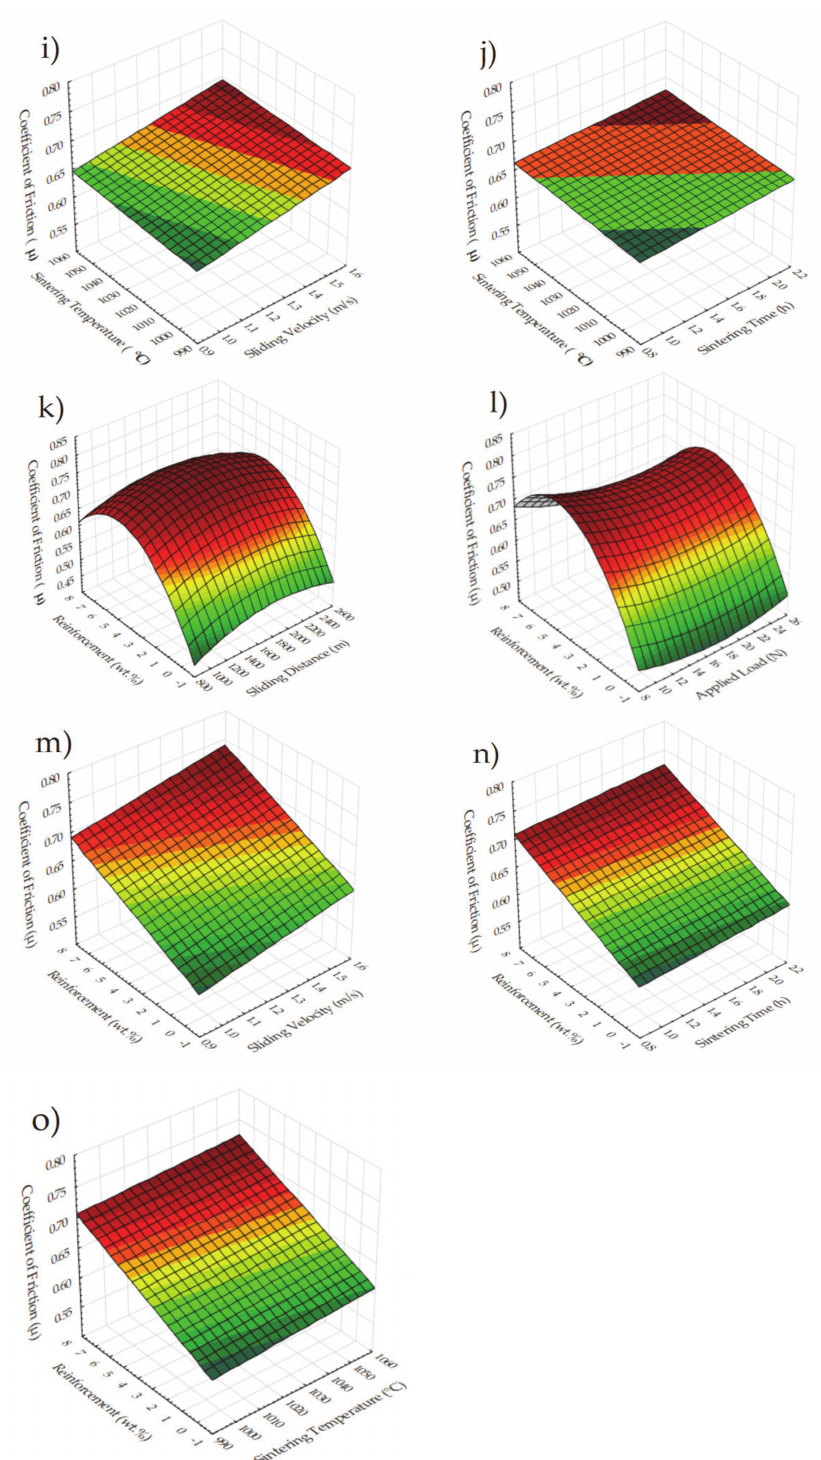
Figure 16. 3D surface plots for the coefficient of friction for the effect of ( a ) Sliding distance and ap- plied load ( b ) Sliding velocity and sliding distance ( c ) Sintering time and sliding distance ( d ) Sintering temperature and sliding distance ( e ) Sintering temperature and applied load ( f ) Sintering time and applied load ( g ) Sliding velocity and applied load ( h ) Sintering time and sliding velocity ( i ) Sintering temperature and sliding velocity ( j ) Sintering temperature and sintering time ( k ) Reinforcement and sliding distance ( l ) Reinforcement and applied load ( m ) Reinforcement and sliding velocity ( n ) Reinforcement and sintering time ( o ) Reinforcement and sintering